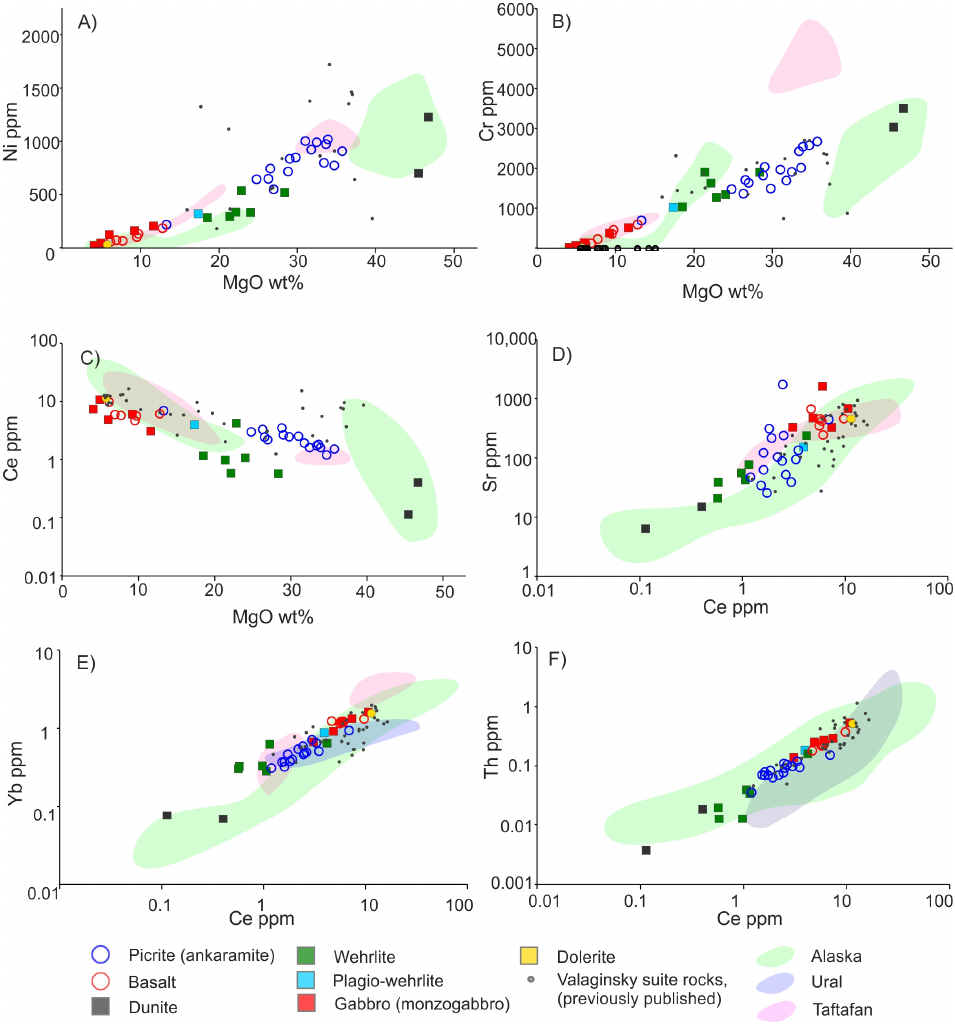
Figure 12. Chemical variation plots of trace elements. ( A ) MgO-Ce plot; ( B ) Ce-Sr plot; ( C ) Ce-Yb plot; ( D ) Ce-Th plot; € MgO-Ni plot; ( F ) MgO-Cr plot. Sources of data for the comparison are in Figure 7.